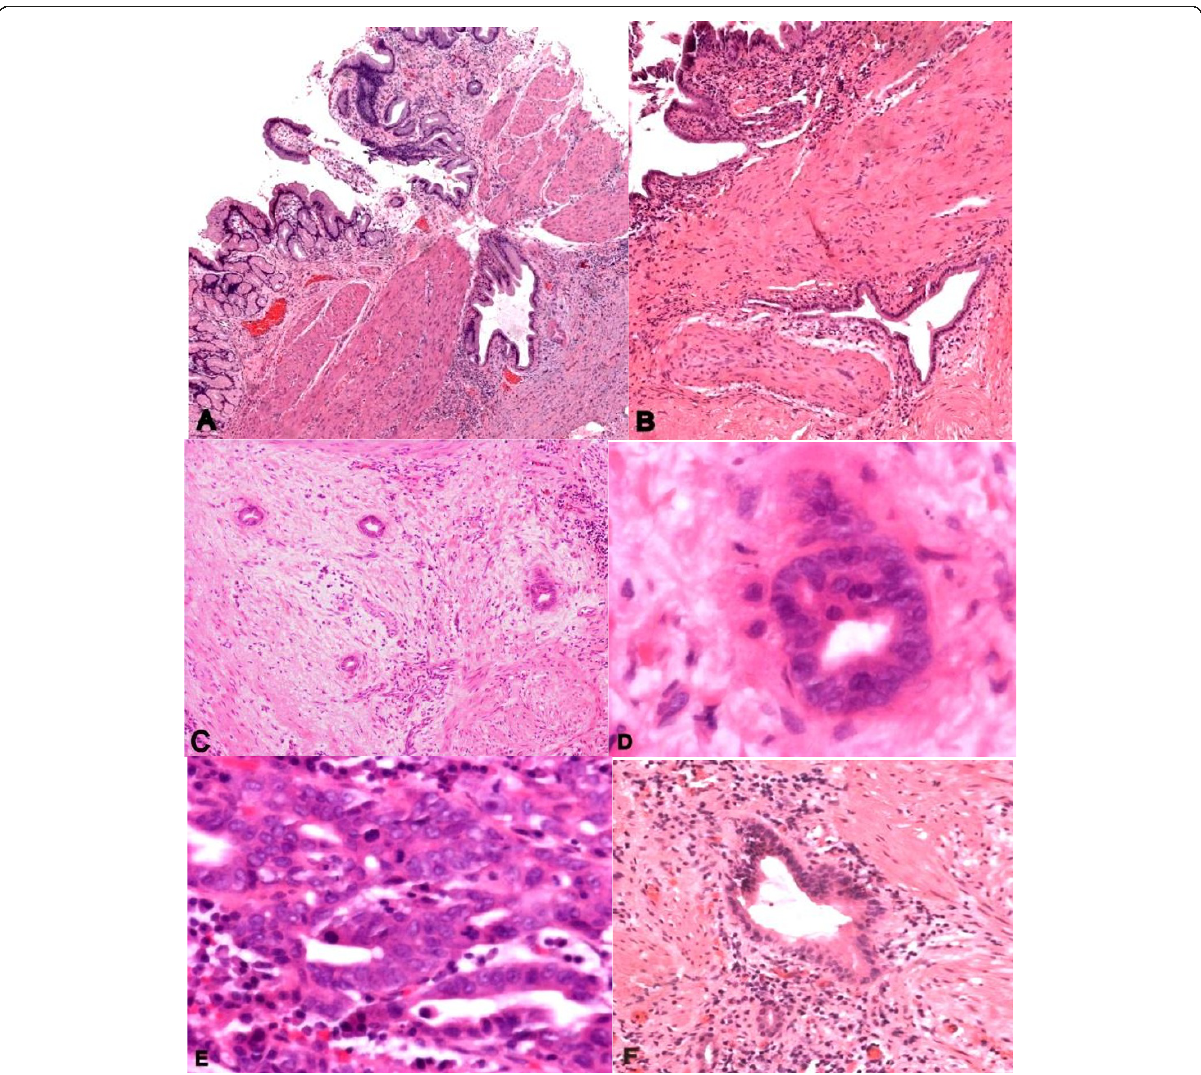
Figure 1 Benign mimicking malignant, and malignant mimicking benign in the gallbladder . A-B: RAS extending transmurally, without any associated dysplasia, C: Glands embedded in bundles of smooth muscle resembling RAS, D: Well-differentiated glandular structures embedded deeply in the gallbladder wall with subtle atypia, E: Foci of back to back arrangement of glands lined by layers of highly atypical columnar cell. Many mitoses presented, F: Diffuse wall thickening with intramural diverticula within the wall, mimicking well-differentiated adenocarcinoma of the gallbladder (H&E